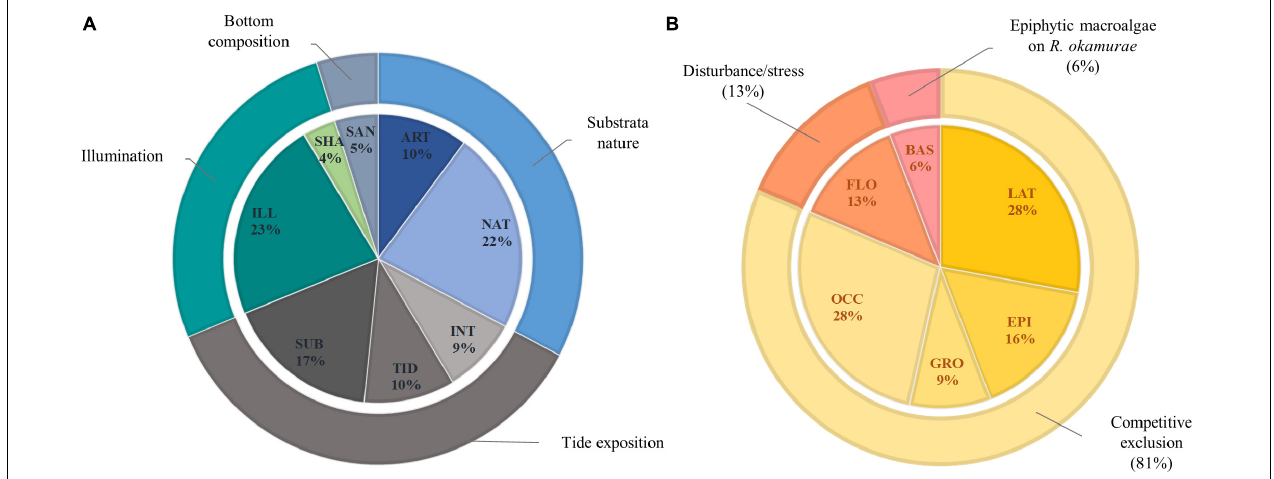
FIGURE 2 | (A) Percentage of total observed interactions between R. okamurae (RO) and the 43 resident macroalgal species present at each habitat surveyed in the study area (ART, artificial substrata; NAT, natural substrata; INT, area extended from the low intertidal to the high intertidal zone; TID, tidepools; SUB, sublittoral zone; ILL, illuminated habitats; SHA, shaded habitats; SAN, sandy habitats near to rocky shores). (B) Percentage of space colonization strategies between RO and the resident macroalgal community [LAT, RO laterally compress the resident species; EPI, RO epiphytes the resident species; GRO, RO grows and develops on the resident species without being attached on it; OCC, RO is established on the free substrata left by the resident species when the latter dies; FLO, RO remains free-floating on the resident species thallus without being attached on it; BAS, RO is epiphyted by the resident species (i.e., RO was observed as